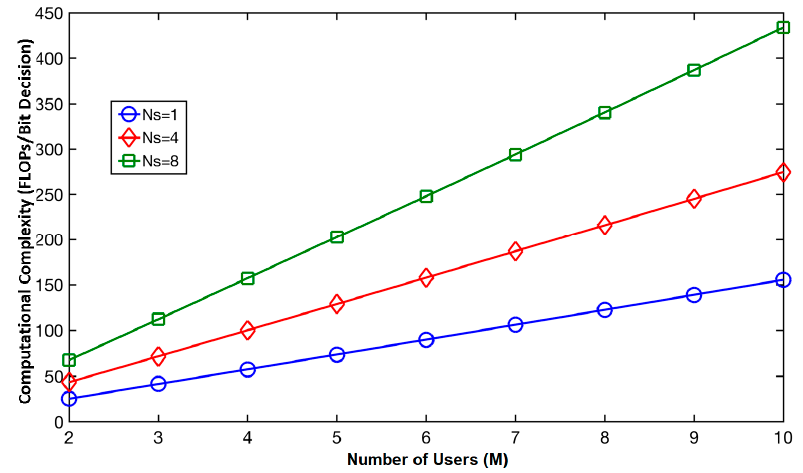
Figure 7. Computational complexity of NOMA receivers. Table 3. Computational time per bit decision by SIC unit.